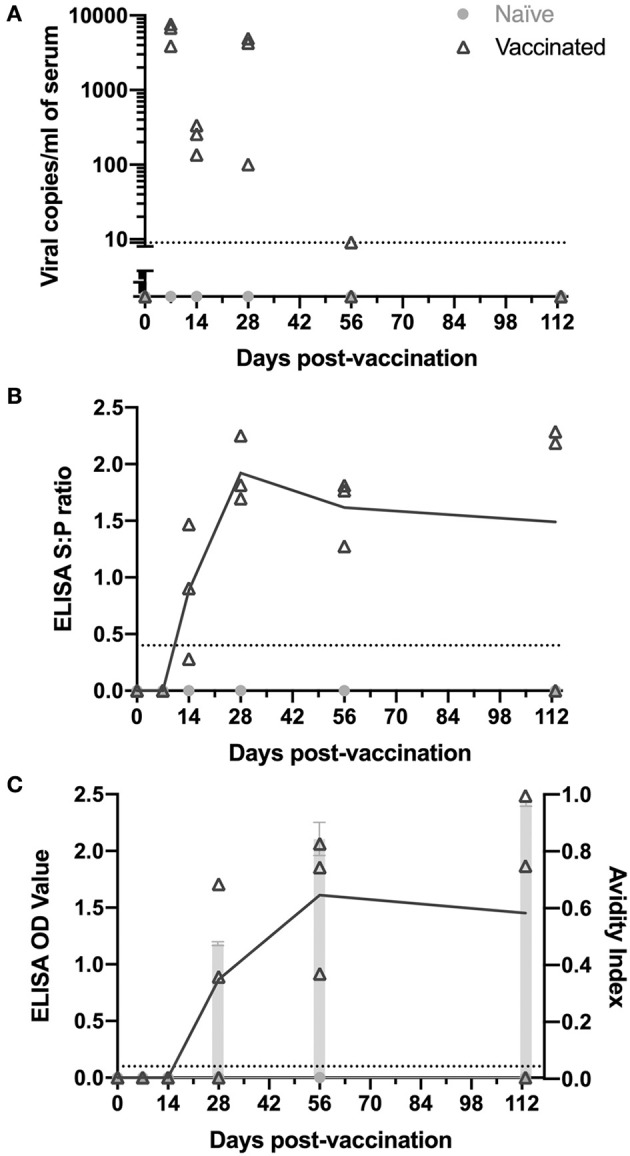
Kinetics of PRRSV viremia and antibodies following vaccination. Animals were vaccinated or not vaccinated at day 0. At each time point (7, 14, 28, 56, and 113 days post-vaccination), three vaccinated and one non-vaccinated animal were sacrificed and serum was obtained. Serum samples were examined for (A) PRRSV viremia levels, (B) PRRSV antibodies by IDEXX ELISA, and (C) nsp7-specific antibodies by ELISA (left y-axis) and avidity index (right y-axis) as shown by light gray bars. Viral copy number and ELISA cut-off values are shown as a dotted line. All naïve animals were non-viremic and antibody negative.